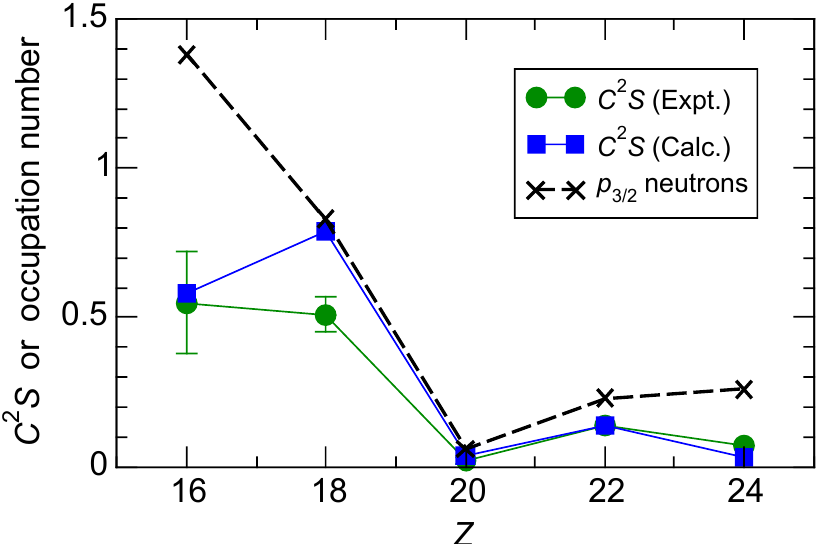
Figure 5. One-neutron removal spectroscopic factors of the 3/2 − N = 28 isotones. The crosses denote the calculated neutron occupation numbers in the ground states of the N = 28 isotones. Data are from Refs. [39] ( Z = 20, 22, and 24), [40] ( Z = 18), and [41] ( Z =